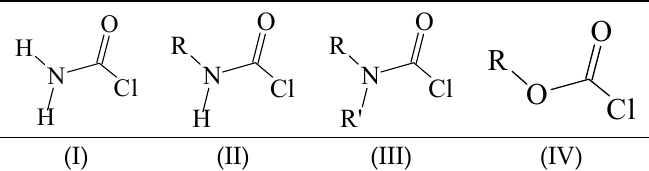
Scheme 1. Standard structural representations for substituted carbamoyl chlorides and chloroformate